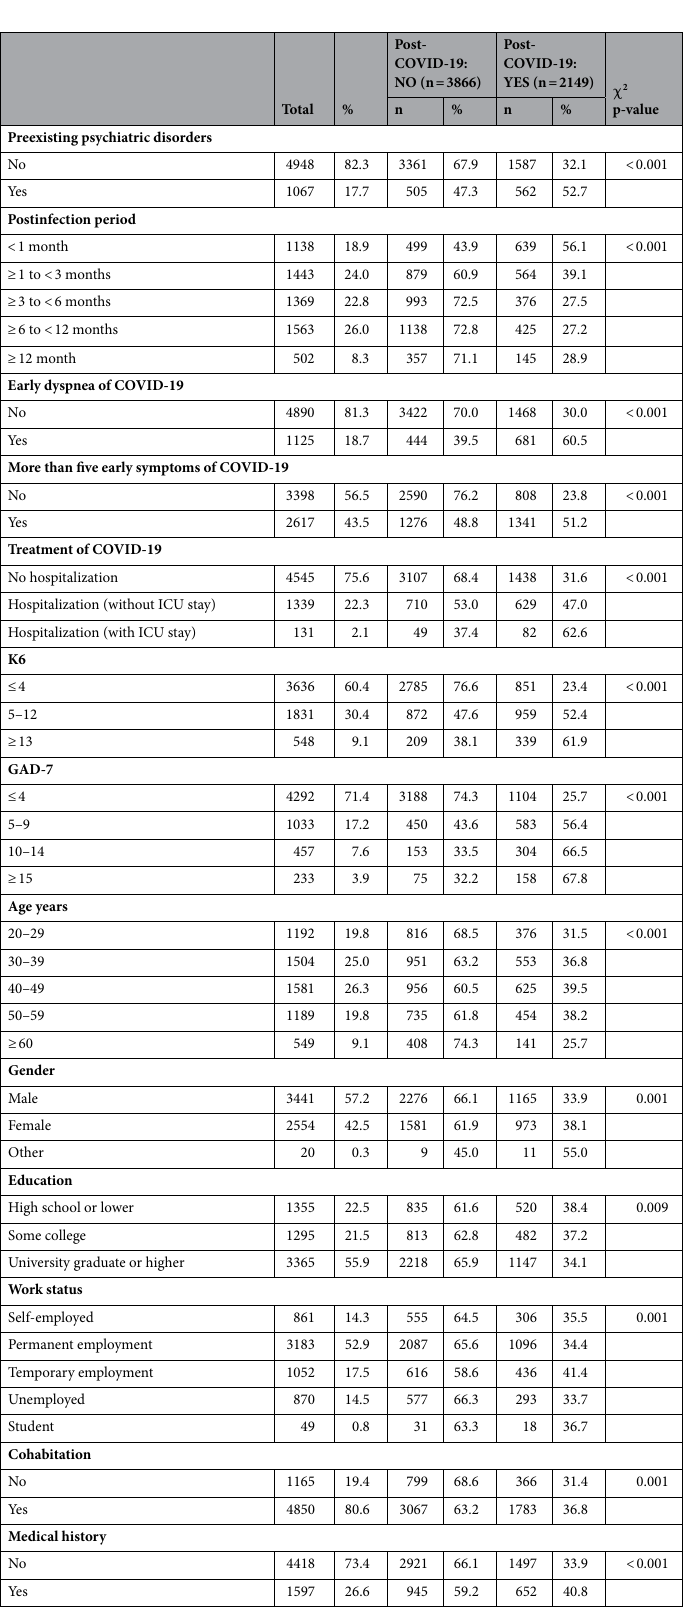
Table 1. Baseline characteristics of study participants by existence of post-COVID-19 (n = 6015). K6 Kessler6, GAD-7 Generalized Anxiety